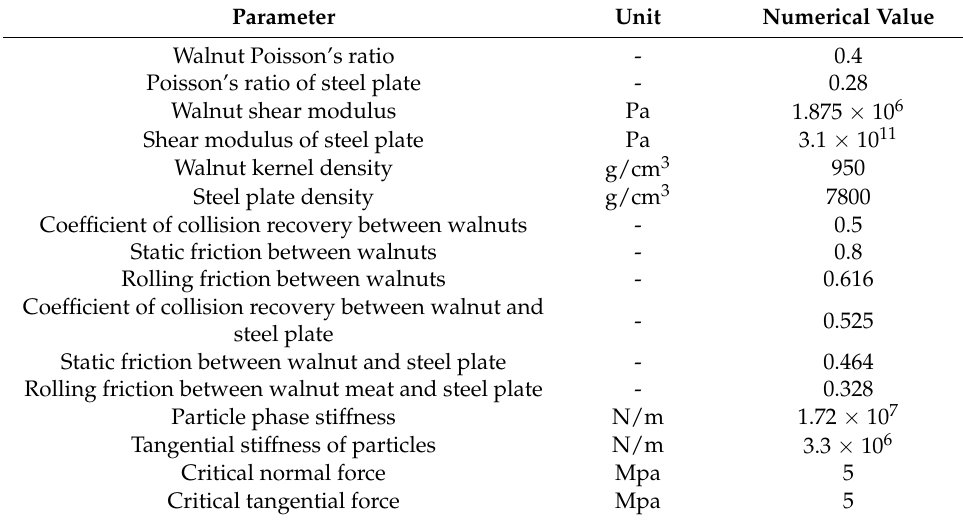
Table 11. The parameters of cylindrical sample used in EDEM.